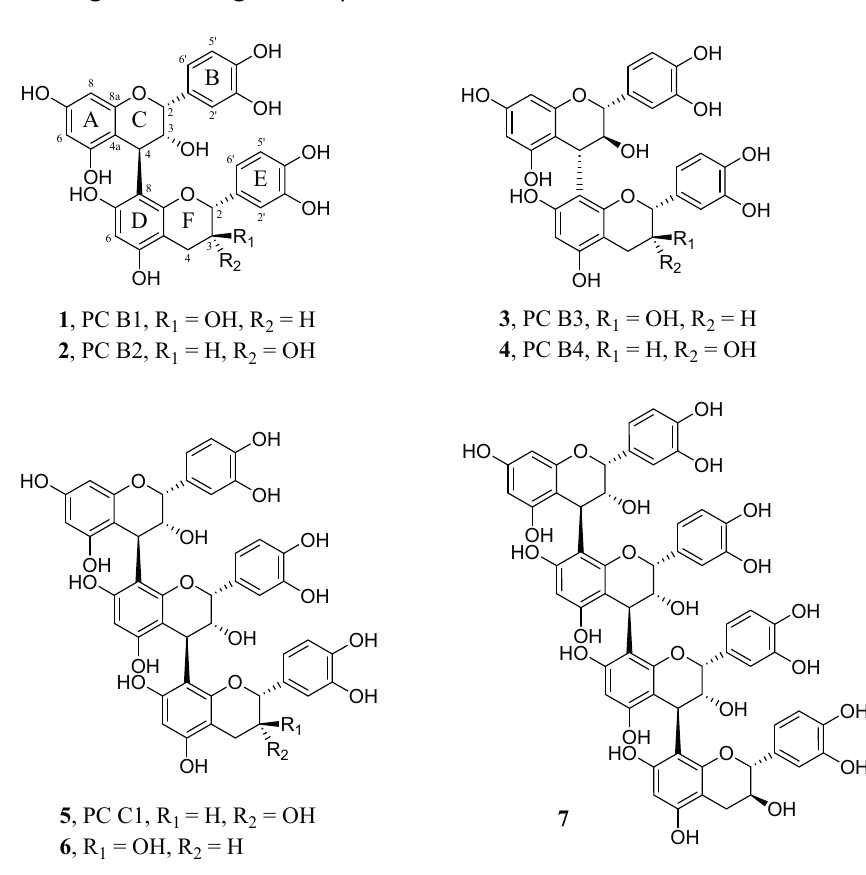
Figure 1. Structures of the isolated procyanidins (PC) 1 – 7